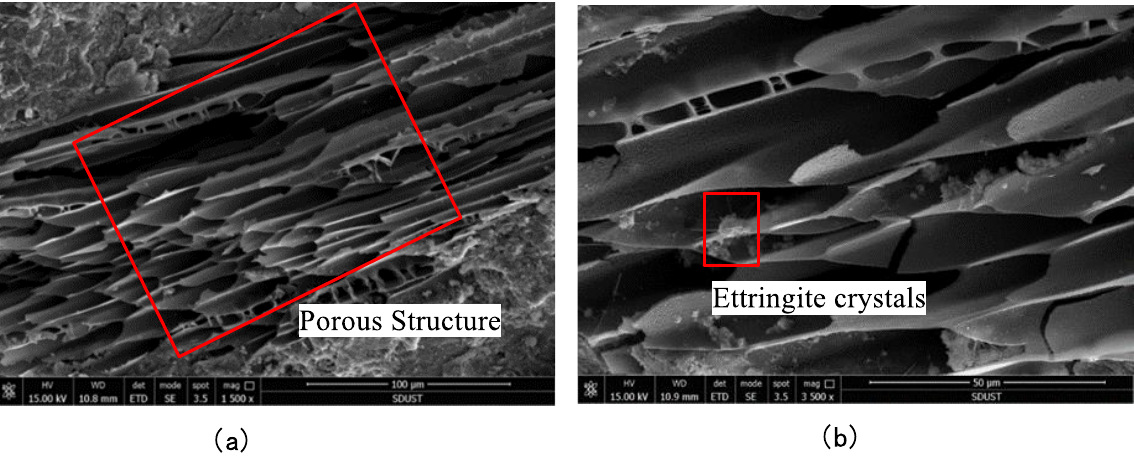
Figure 10. SEM images showing ettringite crystal formation among carbon particles. ( a ) porous structure of carbon particle marked by red box. ( b ) ettringite crystal marked by red box.